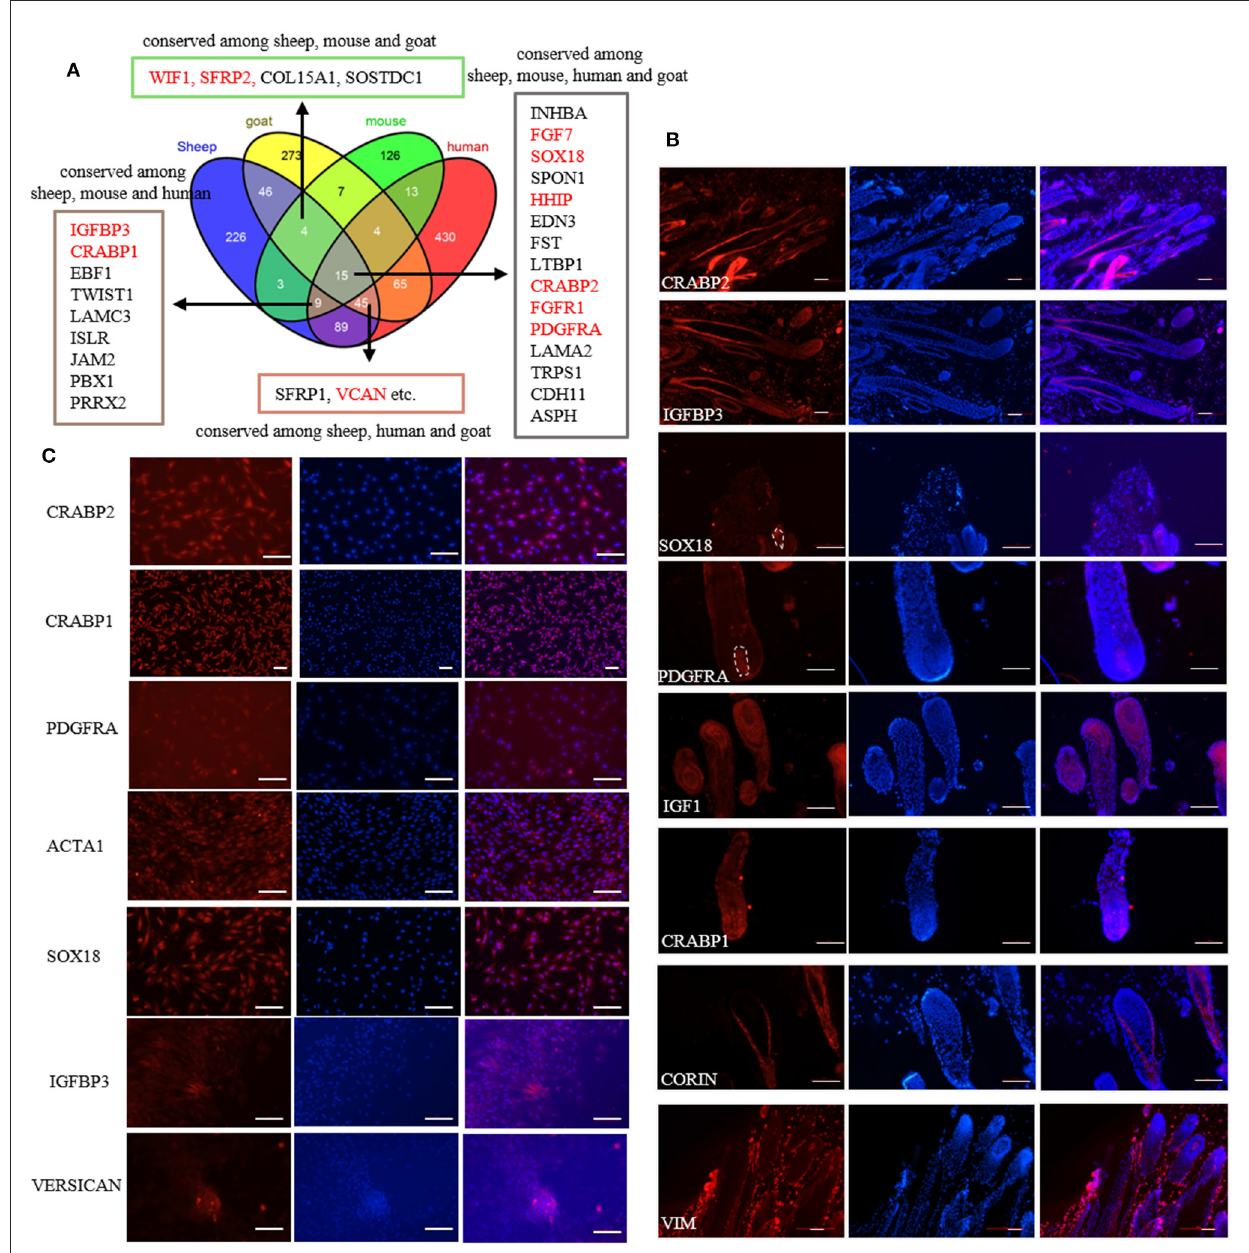
FIGURE1 Identification of marker genes of ovine DPCs. (A) Comparative analysis of dermal papilla cell signature genes from different species. The genes listed in the textbox are conserved among sheep and other two or three species. The genes marked in red were furtherly verified in the subsequent study. (B) Immunofluorescence staining of potential markers genes in skin paraffin section. (C) Immunofluorescence staining of potential markers genes in cultured ovine DPCs. Red fluorescence indicated the expression pattern of the interested protein. Nucleus was stained with Hoechst in blue. Scale bars, 50 µ